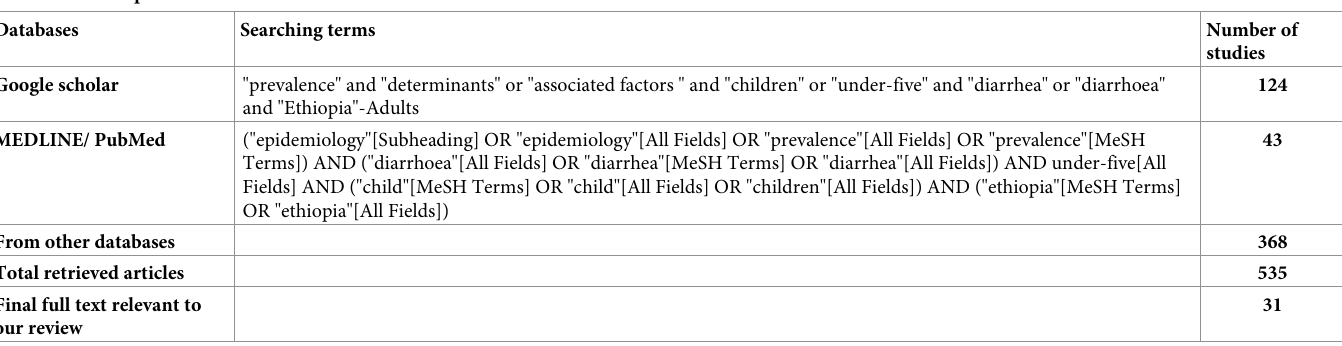
Table 1. Example of searches for the MEDLINE/ PubMed and Google Scholar databases to assess the prevalence and determinants of diarrhea among under-five children in Ethiopia.